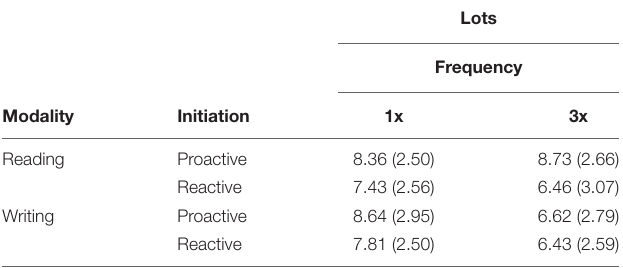
TABLE 6 | Mean lots sent to partner (SDs in parentheses) as a function of modality of phubbing (reading vs. writing), initiation of phubbing (proactive vs. reactive), and frequency of